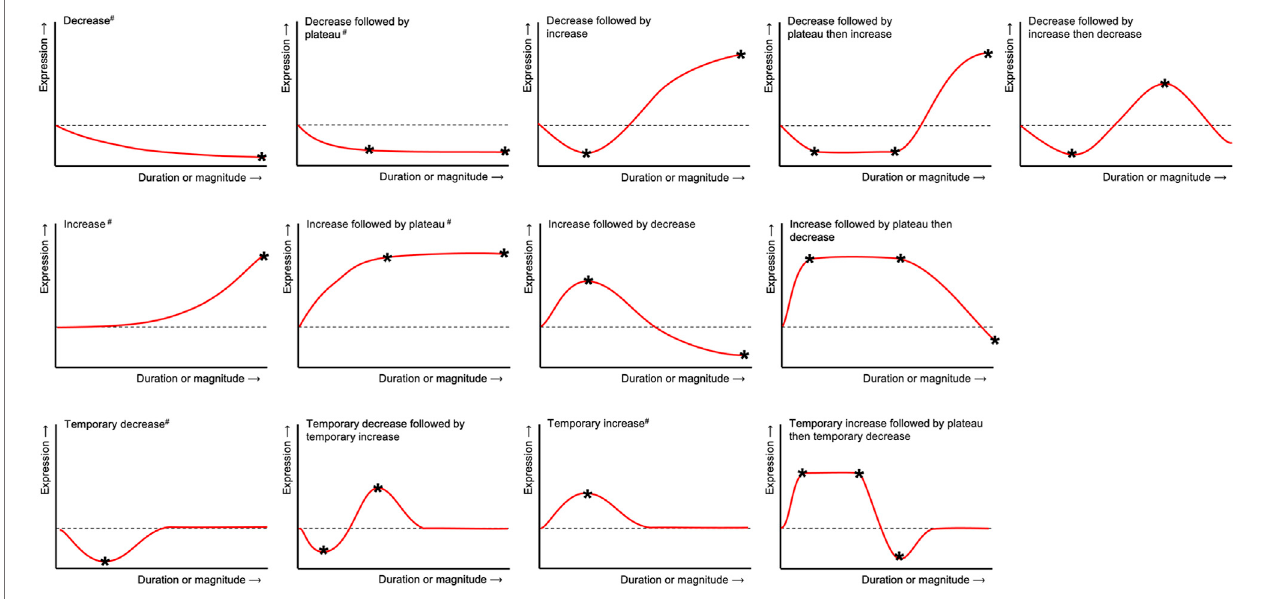
FIGURE 2 | Terms used to describe the general expression patterns in hPDLCs after tension application for each gene, protein or metabolite included herein. Numerical data describing speci fi c maxima and minima (*) was collected and reported in Supplementary Tables S2, S7 . Expression patterns labeled with a double cross (#) were mapped on the protein-protein interaction networks constructed from gene lists shown in Figure 5